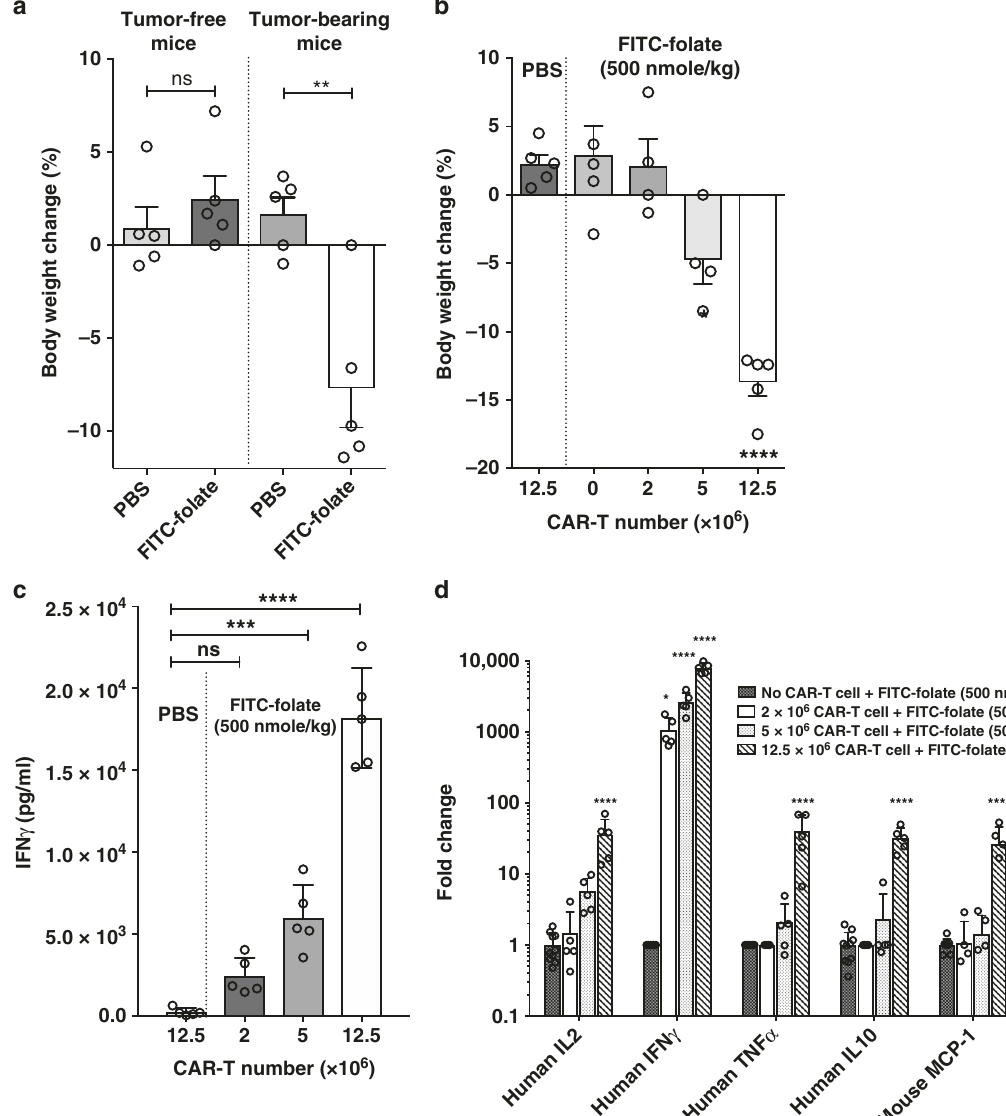
Fig. 3 Dependence of CRS on the presence of anti- fl uorescein CAR T cells, folate receptor-positive cancer cells (MDA-MB-231 cells) and FITC-folate adapter in vivo. a Bodyweight change (%) determined 4 days after anti- fl uorescein CAR T cell (5 × 10 6 ) infusion into either tumor-free or tumor-bearing mice in the presence or absence of FITC-folate (500 nmole/kg administered on days 1 and 2). b Effect of CAR T cell number on bodyweight change (%) (day 4) in tumor-bearing mice after administration of either PBS or 500 nmole/kg FITC-folate on days 1 and 2. c Effect of CAR T cell number in tumor- bearing mice on plasma IFN γ concentration on day 4. d Effect of CAR T cell number (injected on day 1) on serum cytokine concentrations (determined on day 4) following administration of 500 nmole/kg FITC-folate on days 1 and 2. n = 5 mice per group. Bar graphs represent mean ± s.e.m. A t -test for panel a and one-way ANOVA with post-hoc Dunnett tests were performed for all other panels (*denotes a p- value < 0.05, ** < 0.01, *** < 0.001, **** < 0.0001, ns = not signi fi 500 nmole/kg FITC-folate promoted rapid and continuous weight loss, leading to the required euthanasia of the fi ve mice by day 8.